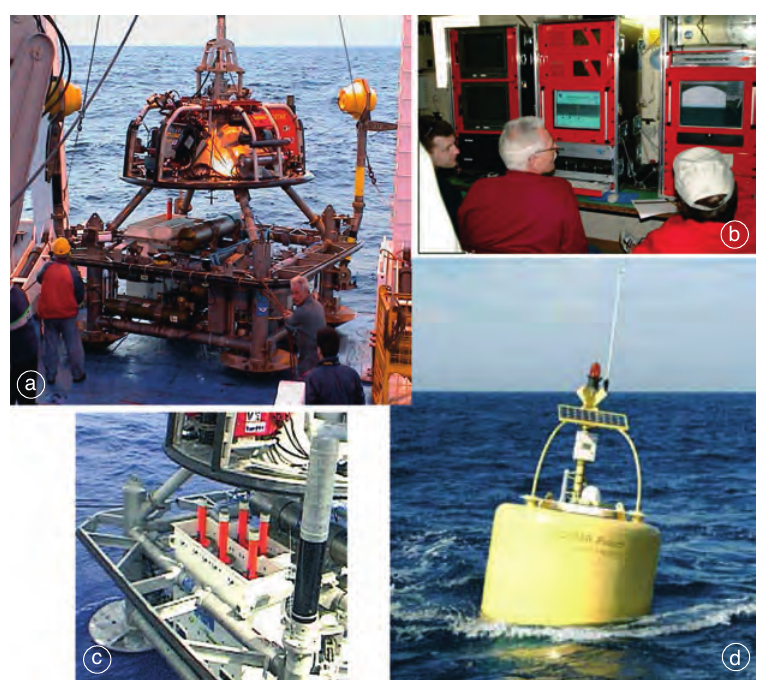
Fig. 9a-d. The complete GEOSTAR sub-systems: a) Bottom Station, which includes DACS, power supply, un- derwater acoustic communications and scientific payload, with MODUS on the top; b) MODUS ship-based re- mote control system; c) surface communication buoy (GEOSTAR-2 configuration); d) five M ESSENGERS within the Bottom Station, the orange ARGOS antennas are visible (see also Favali et al. ,